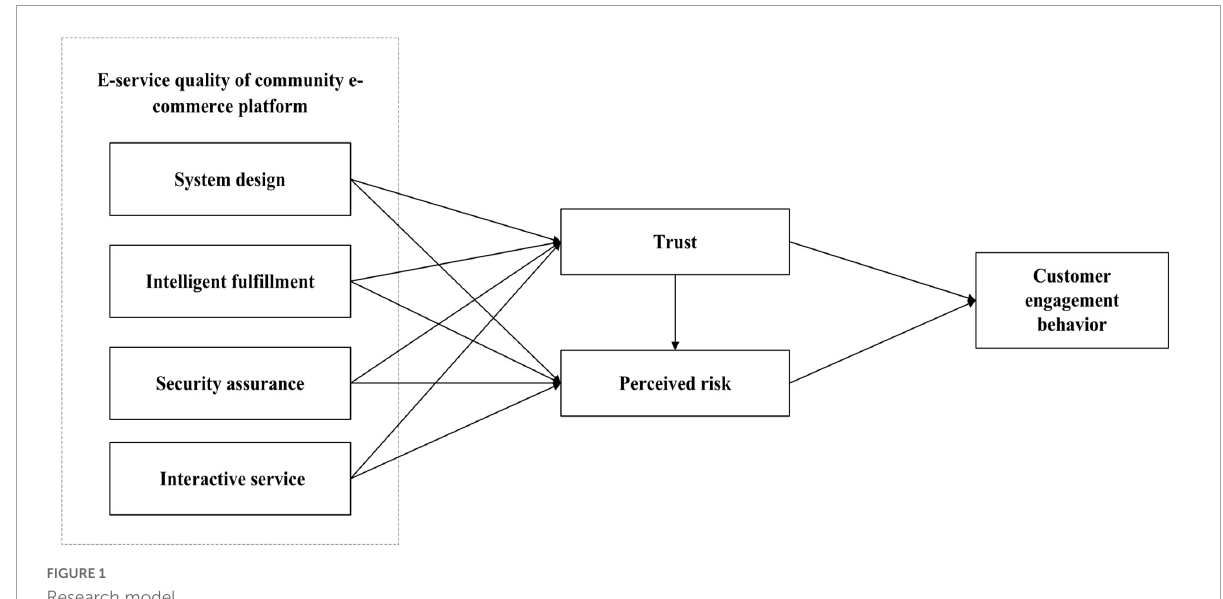
FIGURE1 Research